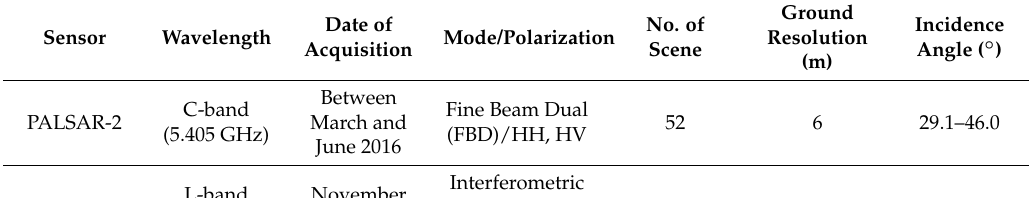
Table 1. Summary of satellite images used in this study.